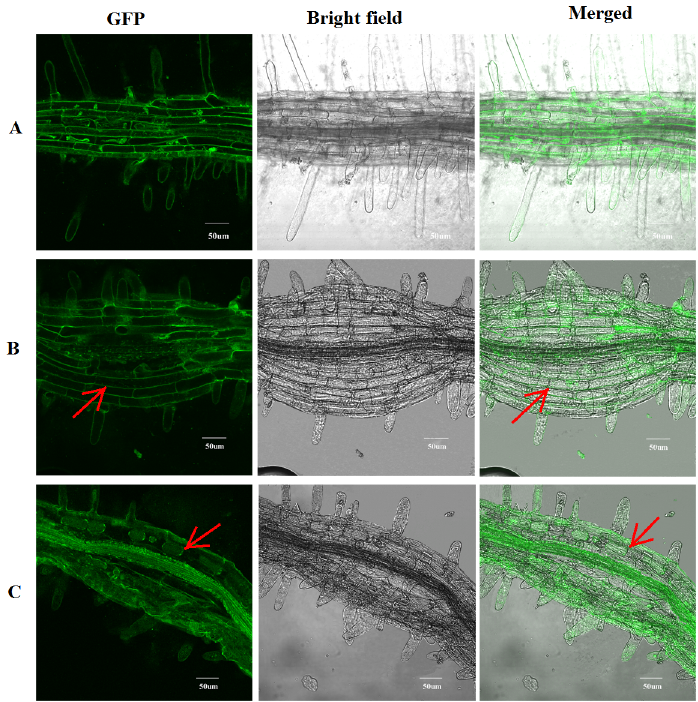
Fig 6. Subcellular localization of CkPGIP1::GFP and Super1300::GFP in transgenic Arabidopsis. A. Super1300::GFP. B. Normal CkPGIP1::GFP. C. plasmolyzed CkPGIP1::GFP. Plasmolysis was induced with 0.8 M mannitol for 10